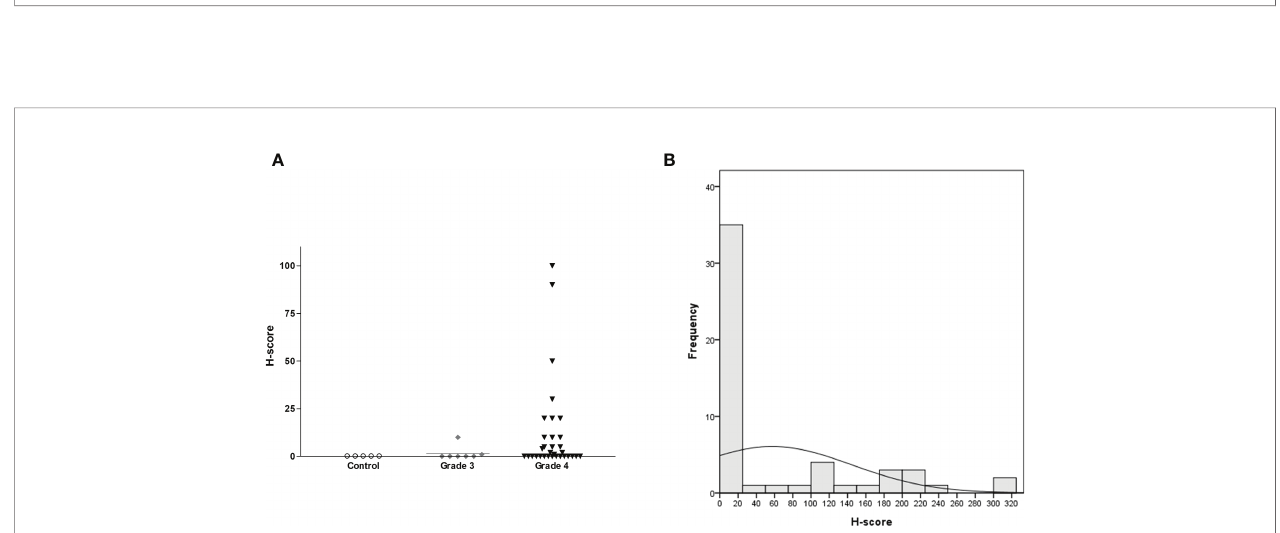
FIGURE 6 | H-score distribution for IL13R a 2 IHC staining according to glioma grade with non-tumorous brain tissue as a negative control shown as a (A) scatterplot ( n = 58, horizontal bar representing median value) and (B) histogram ( n = 53 for MG). IHC, immunohistochemistry; MG, malignant glioma.